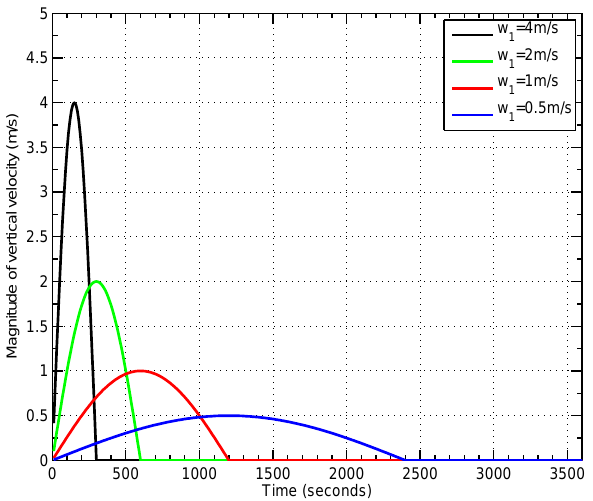
Fig. 1. Vertical velocity fields as a function of time, as applied to the 1-D column equally at every vertical level.